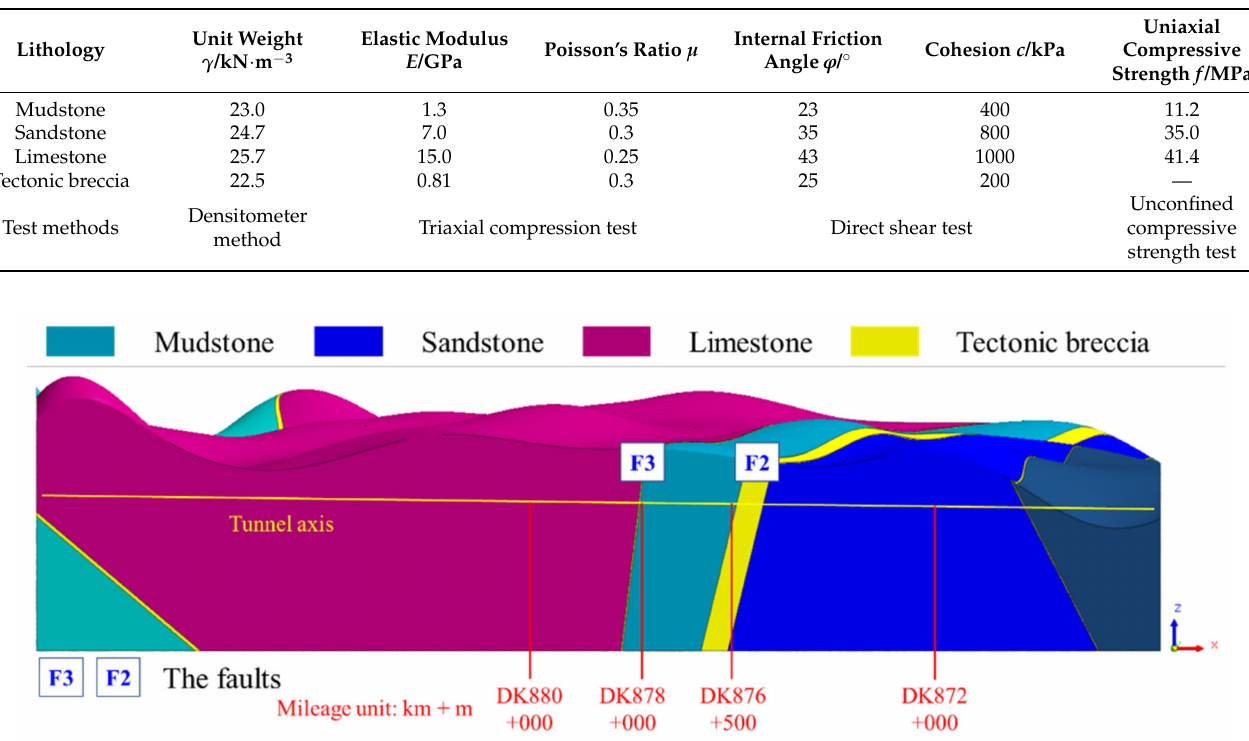
Figure 3. 3D geological